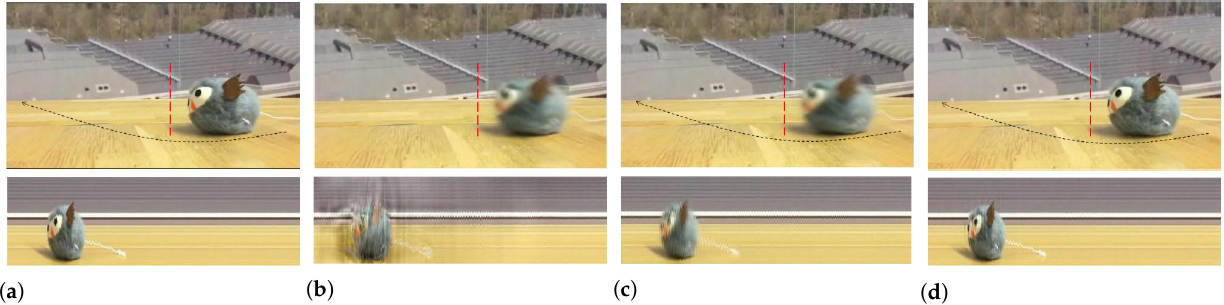
Figure 4. A cat toy vibrating at a high frequency, along with the large amplitude movement of a circle trajectory depicted by the black arrow. Four frames indicating the toy’s trajectory are shown in each top row, the bottom rows show the spatio-temporal line corresponding to the green line in the relevant video frames. ( a ) Original video. ( b ) Phase-based video magnification. ( c ) Eulerian-acceleration mag- nification. ( d ) Our proposed spectrum-aware magnification. The proposed magnification approach can clearly reveal the vibration of the cat toy without inducing blurs and artifacts